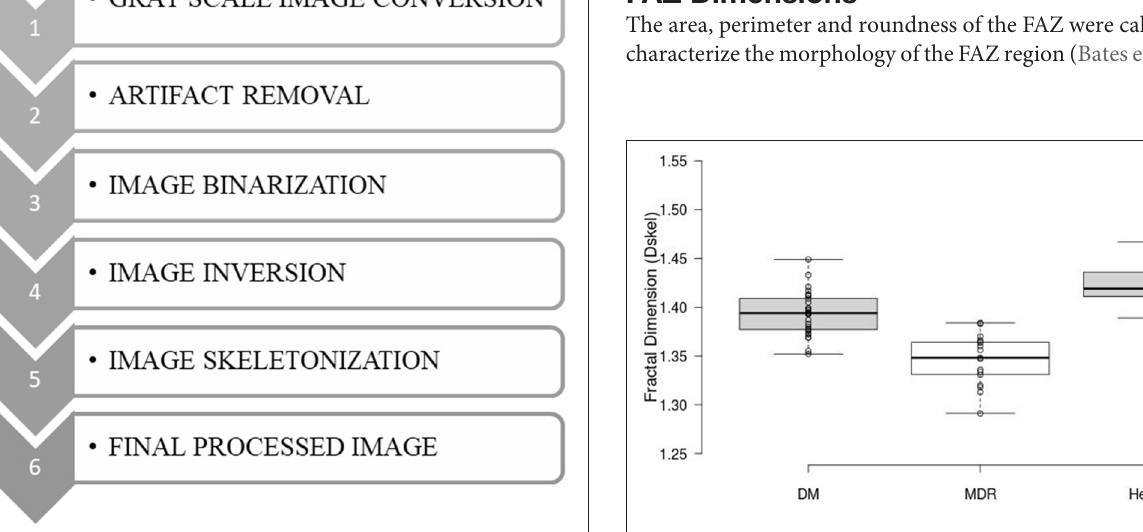
FIGURE 1 | Sketch diagram of skeletonized box dimension ( D skel ) obtained by the box-counting